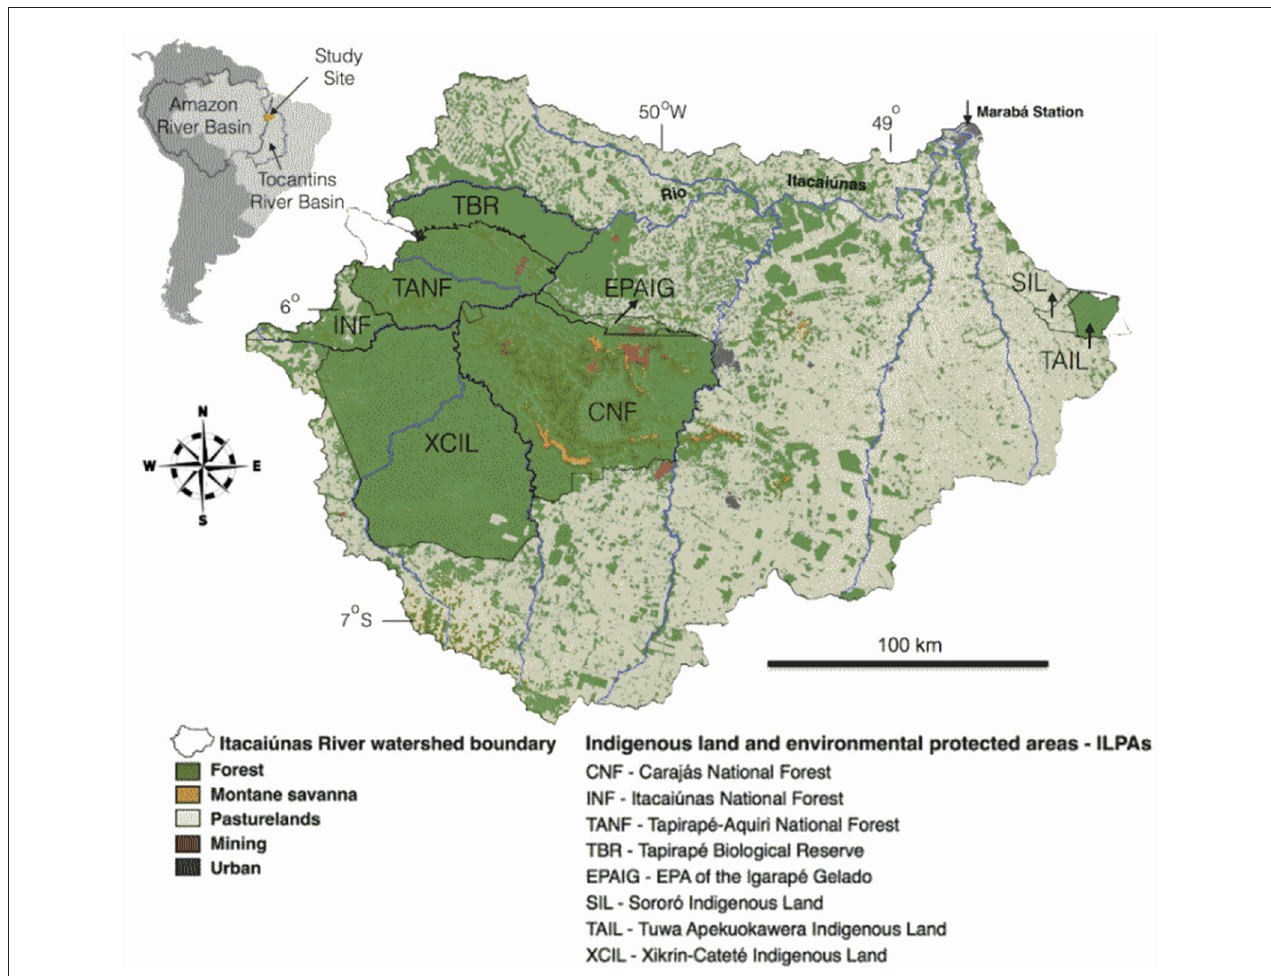
FIGURE 1 | Temporal and spatial variation in land cover and land use in the IRW in 2013. Polygons define the boundaries of indigenous lands and conservation units. The Marabá station is located in the extreme northeast. Source: Adapted from Souza-Filho et al.